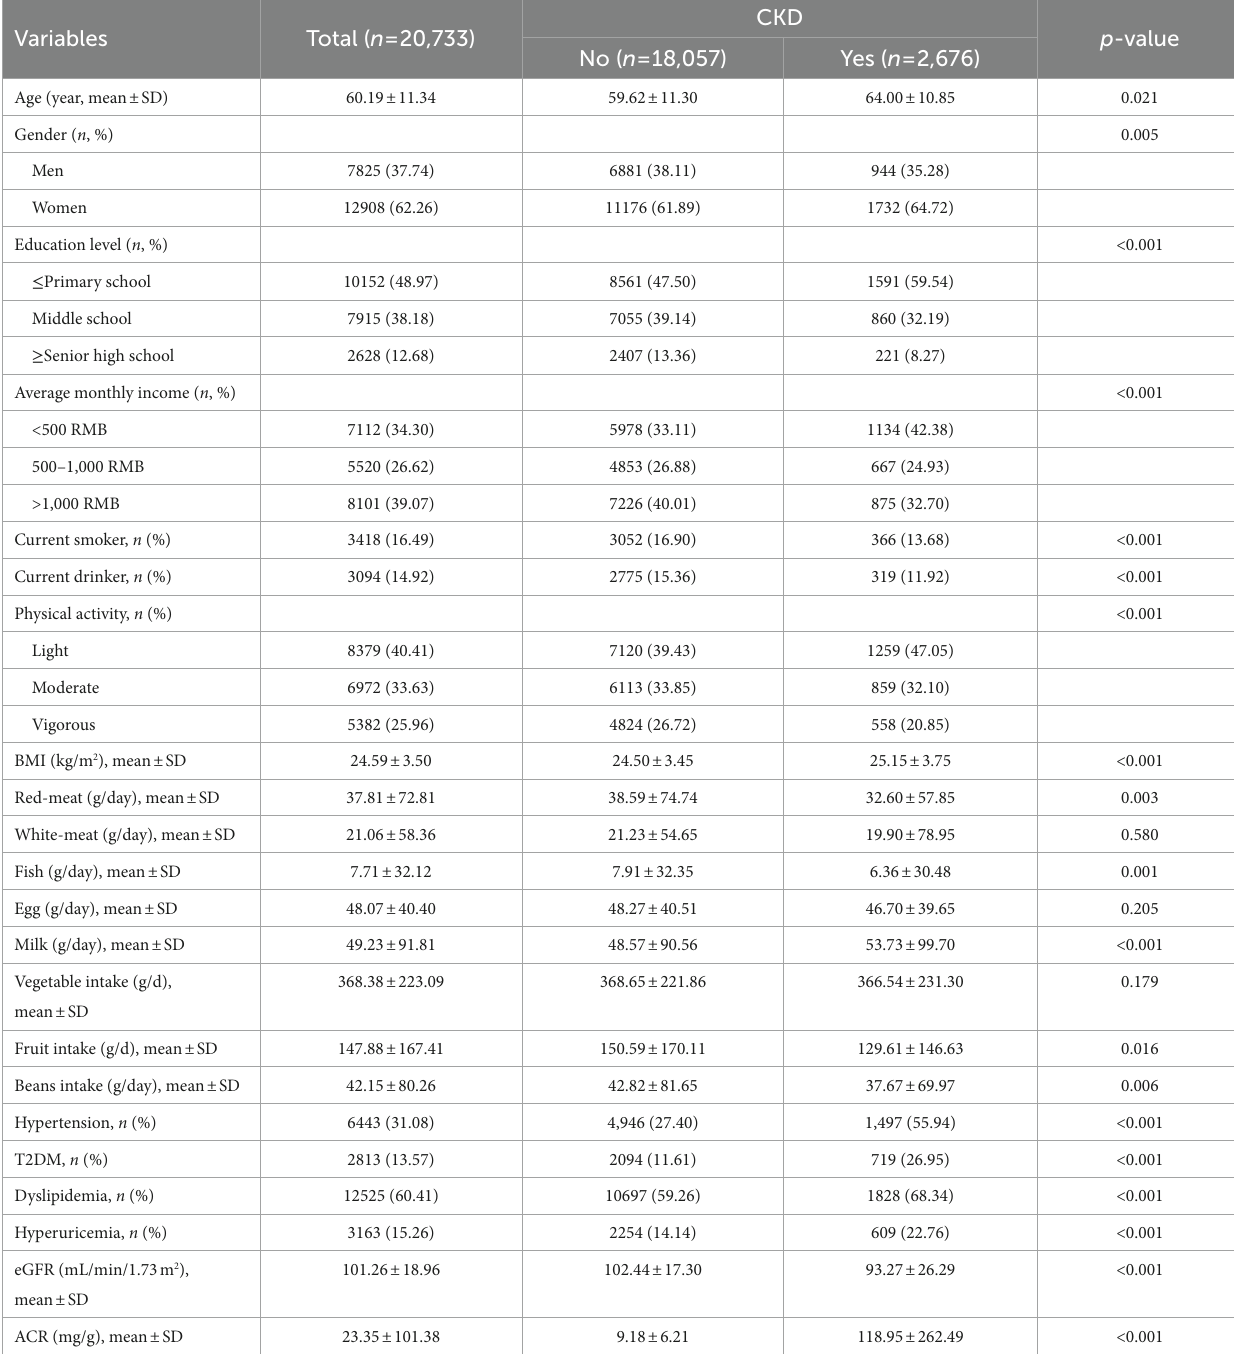
TABLE 1 Basic characteristics of study participants with and without CKD ( n = 20,733).